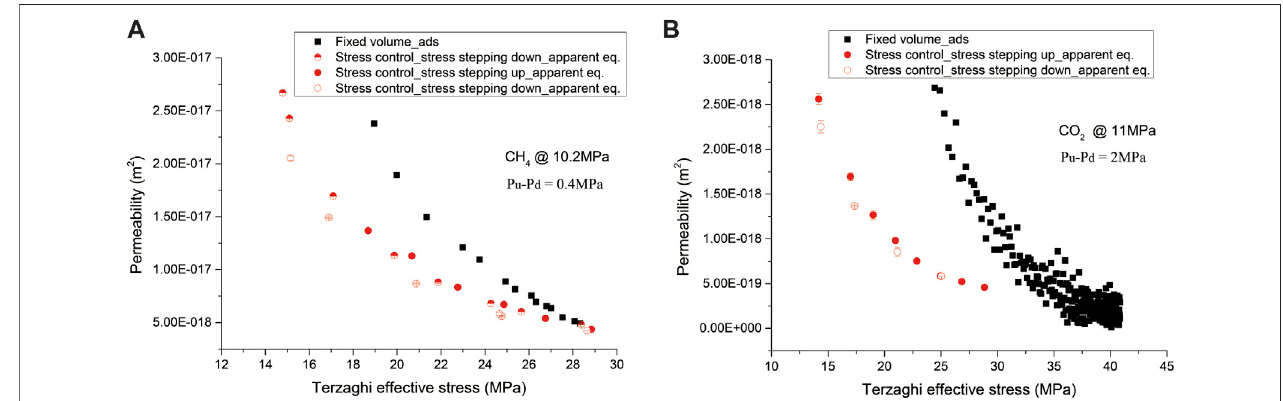
FIGURE6| PermeabilitytoCH 4 shownin (A) andtoCO 2 shownin (B) ,performedunderthe fi xedvolumeversusthe fi xedstressboundarycondition,employingthe same pore fl uid pressure, plotted against Terzaghi effective stress. The black and red dots represent the data points measured under the fi xed volume and fi xed stress boundary conditions,